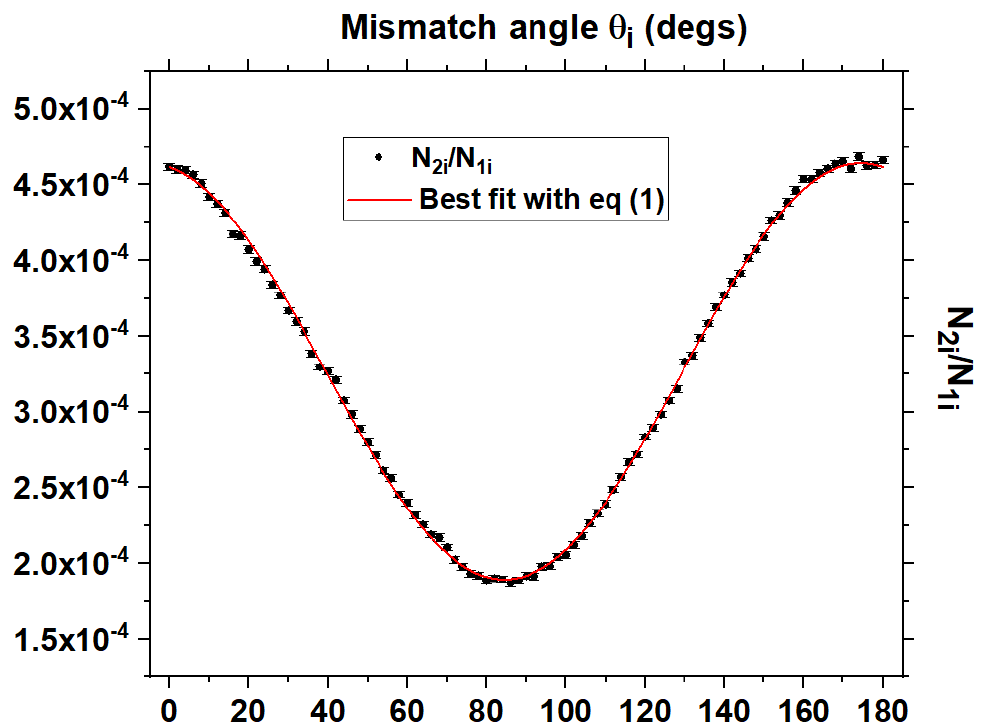
Figure 2. Experimental values for N 2 ( θ i ) / N 1 i (black dots) fitted with Equation (1), shown as red straight curve. On the horizontal axis are reported the mismatch angles θ i = 0 ◦ , . . . ,180 ◦